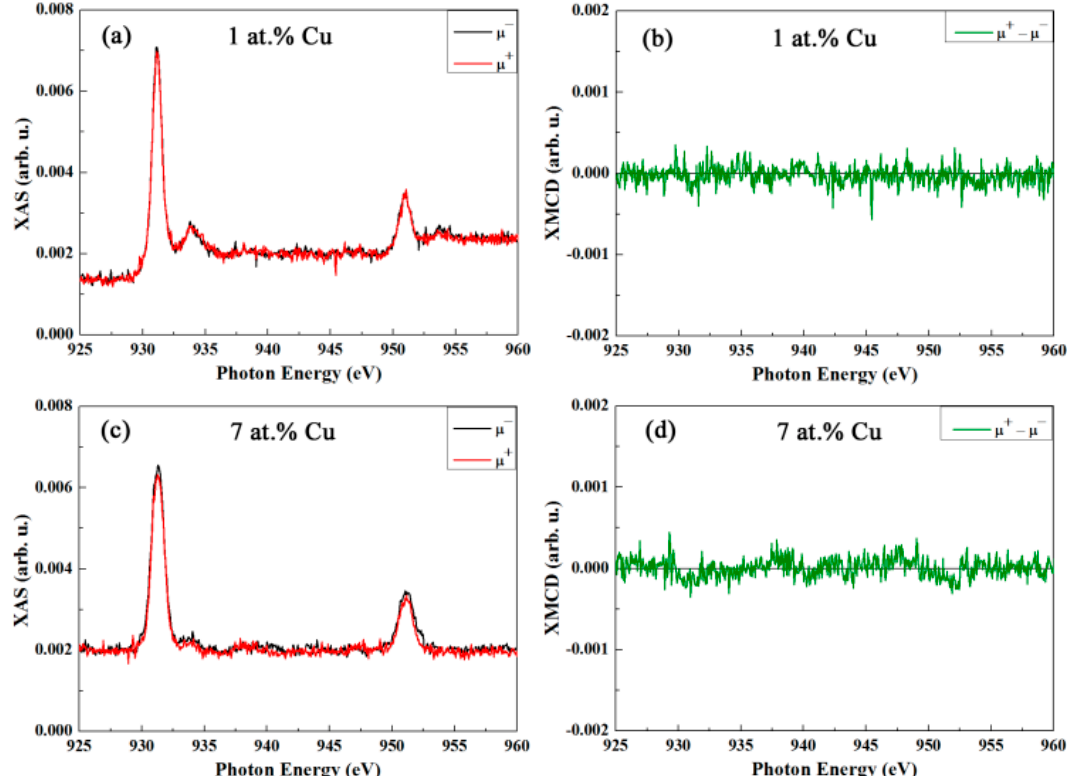
Figure 6. ( a , c ) Cu L 3,2 edge X-ray absorption spectroscopy(XAS) spectra, measured in total electron yield mode for right ( μ + ) and left ( μ − ) circularly polarized light, recorded at room temperature in an applied magnetic field of 50 kOe for the SnO 2 powders doped with ( a ) 1 at.% Cu and ( c ) 7 at.% Cu, respectively. ( b , d ) are the corresponding X-ray magnetic circular dichroism(XMCD) signals (i.e., difference between right and left circularly polarized light) for the SnO 2 powders doped with 1 and 7 at.% Cu, respectively.